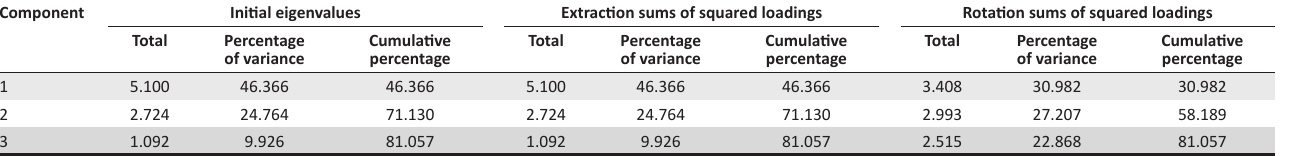
TABLE 3: Initial eigenvalues and rotated eigenvalues of principal component analysis performed on indicators.